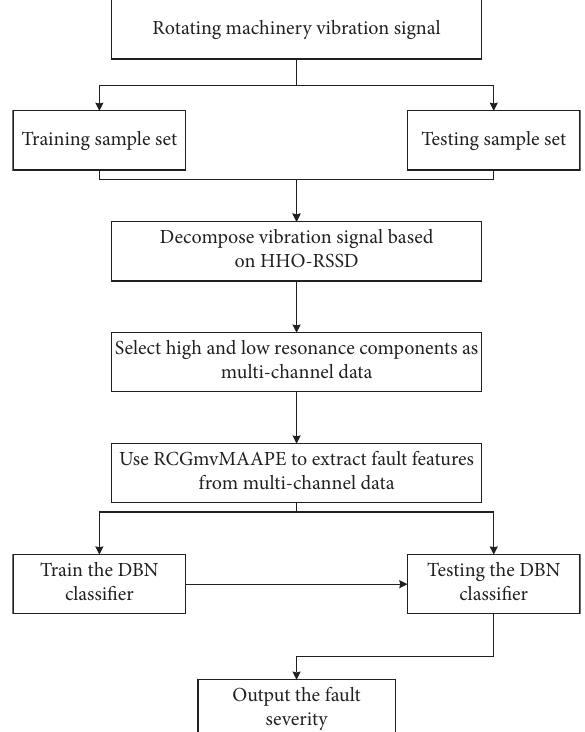
Figure 6: The technical implementation